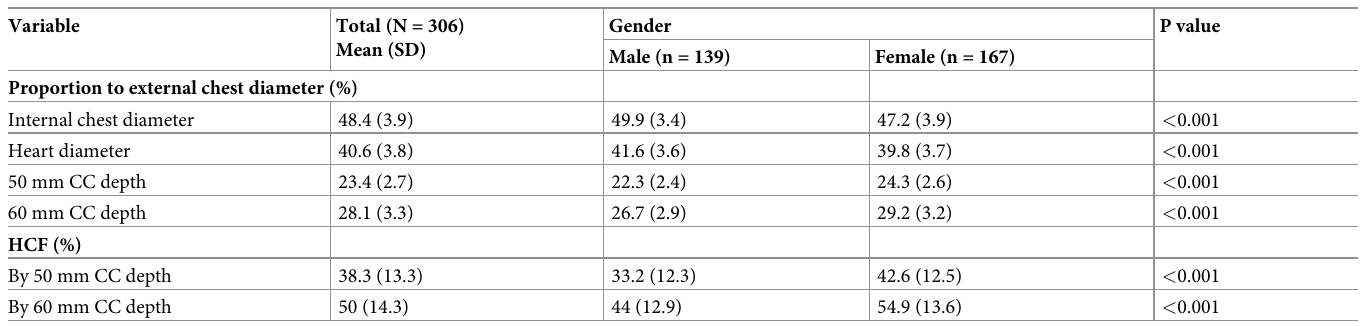
Table 3. HCF and proportion of chest compartments to external chest diameter, based on gender.